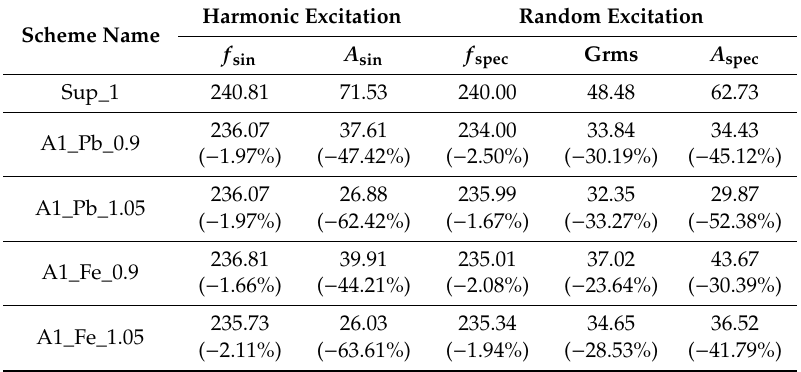
Figure 18. Influence of filling coefficient on the amplitude of amplification coefficient: ( a ) Sinusoidal excitation; ( b ) Random excitation. Table 12. Effect of particle filling coefficient.